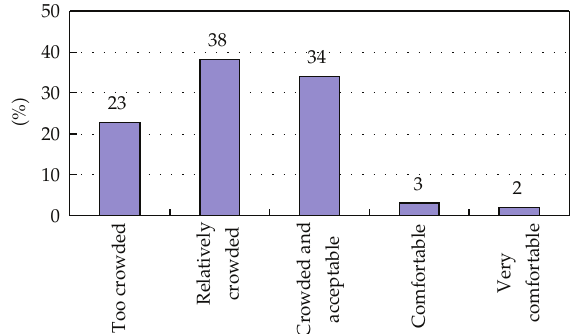
Figure 9: Perception of the comfort for riding bus or railway.